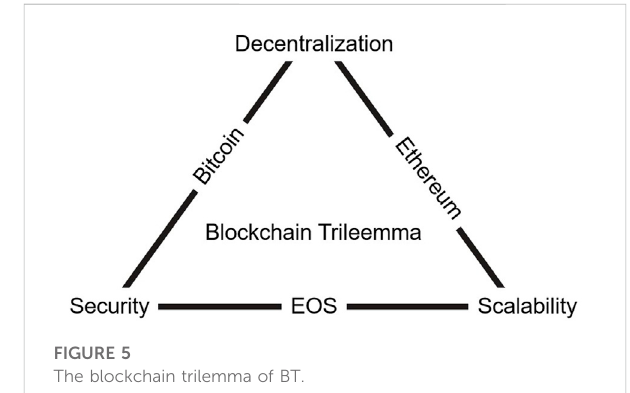
FIGURE 5 The blockchain trilemma of